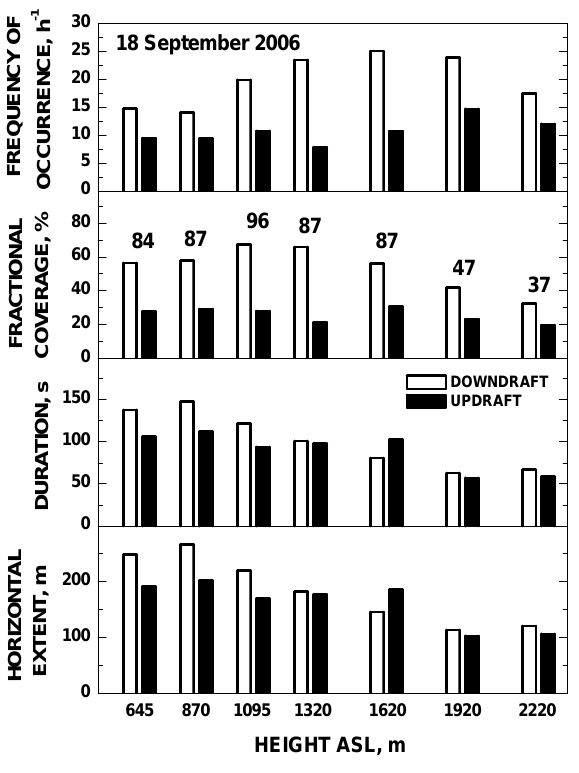
Fig. 8. Same as Fig. 6, except for 18 September 2006, 1020–1905